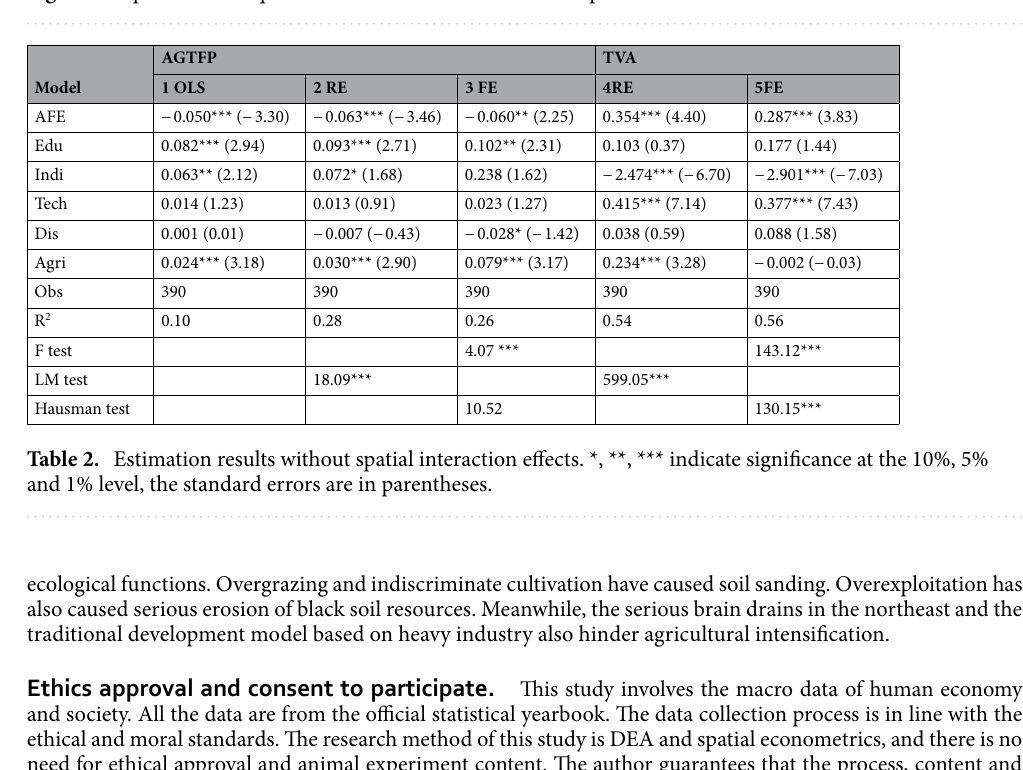
Figure 4. Spatial and temporal characteristics of AGTFP in 30 provinces.